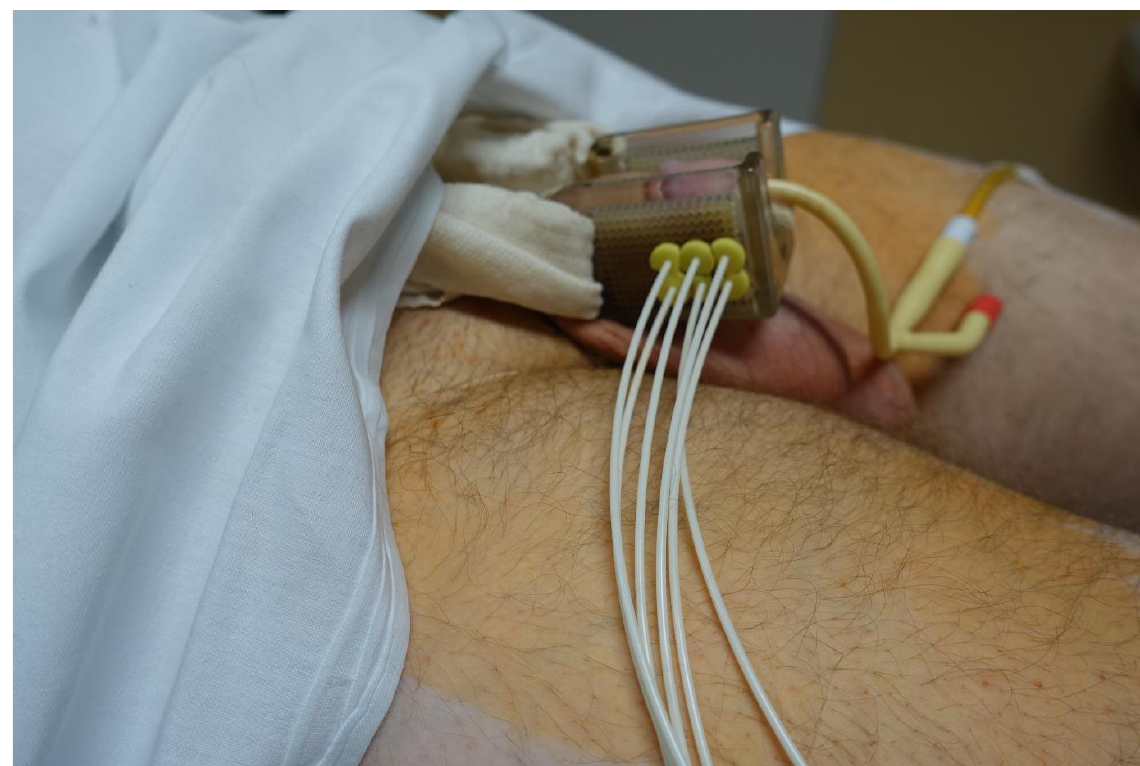
Figure 8. Template for CT-compatible brachytherapy.